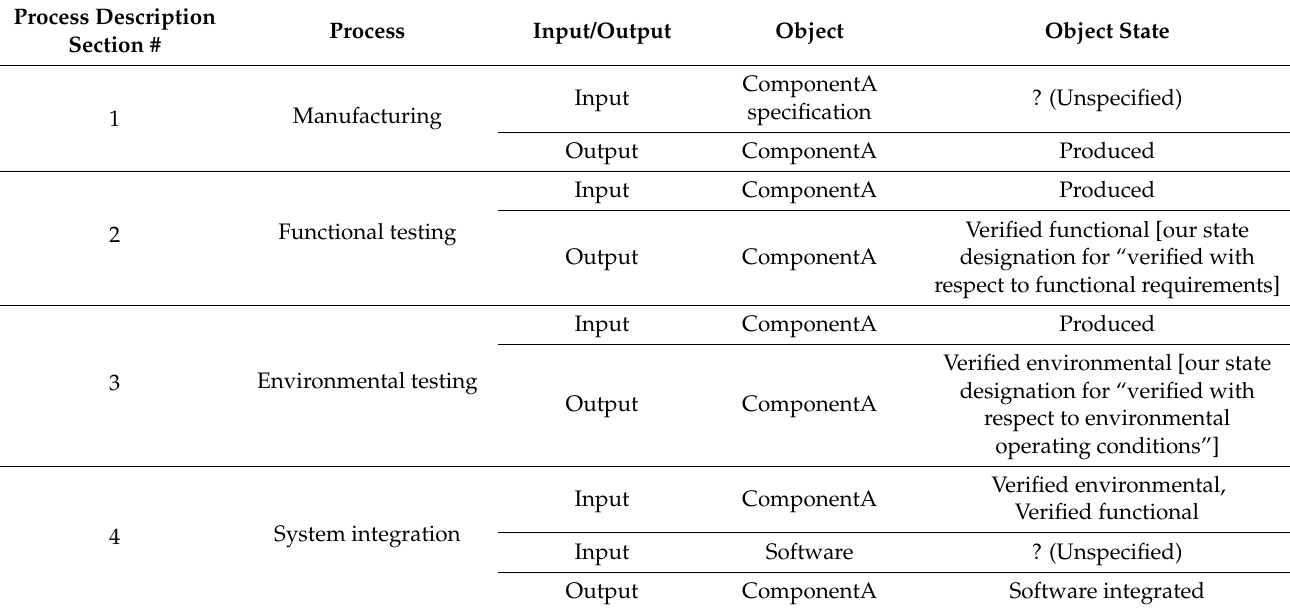
Table 2. Process description analyzed for Object Process Methodology (OPM) modeling. Process Description